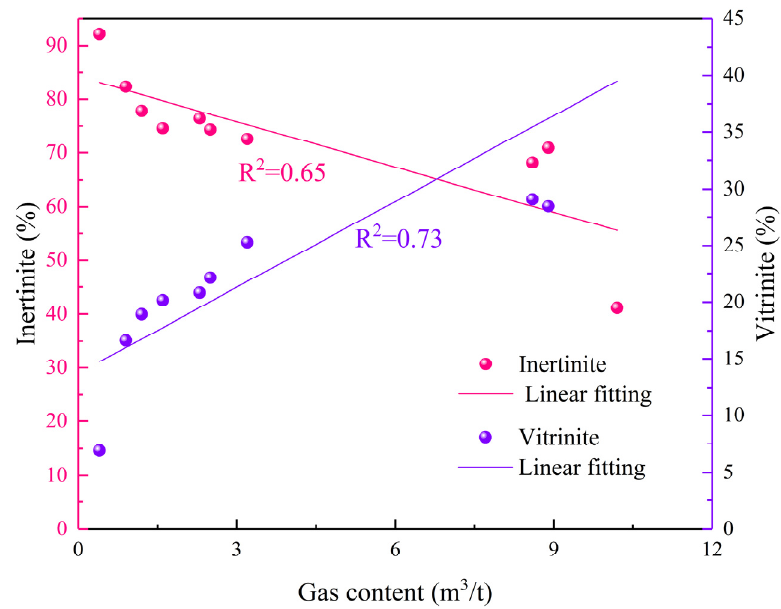
Figure 12. Correlation between gas content and macerals.